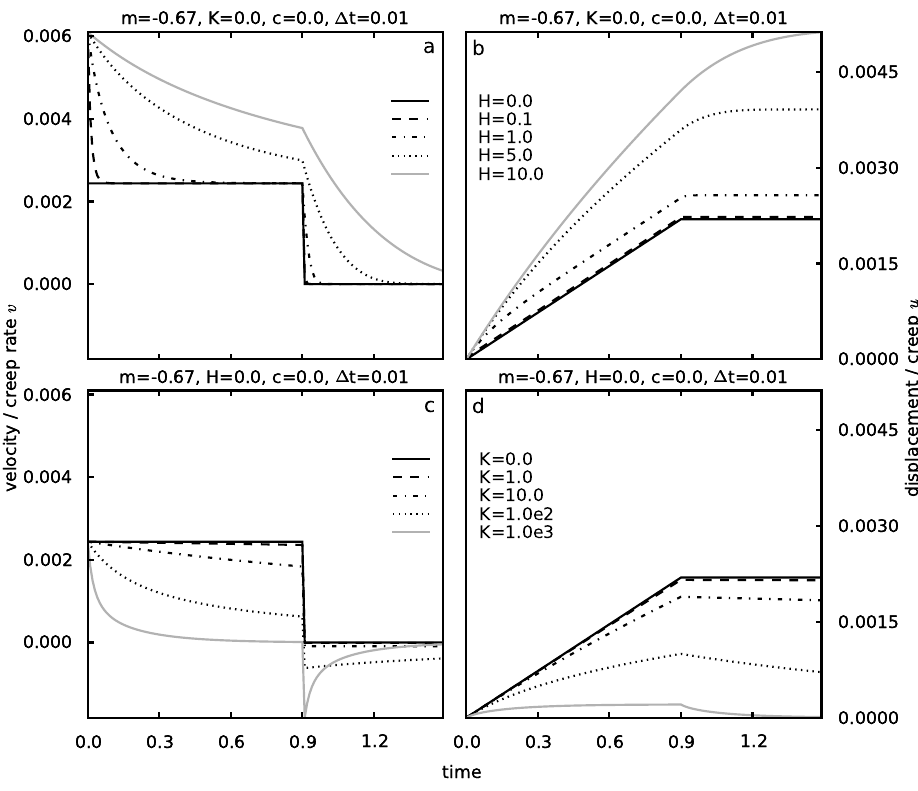
Fig. 2. (a, c) Velocity (creep rate) v at the slab surface as function of time. (b, d) Displacement (creep) u at the slab surface as function of time. In (a, b), solutions of v and u are displayed for different values of the dimensionless number H while K = 0. In (c, d), solutions of v and u are displayed with H = 0 and varying K . Other parameters are as displayed in the plot headers. All fields ( u , v , t ) are non-dimensional.